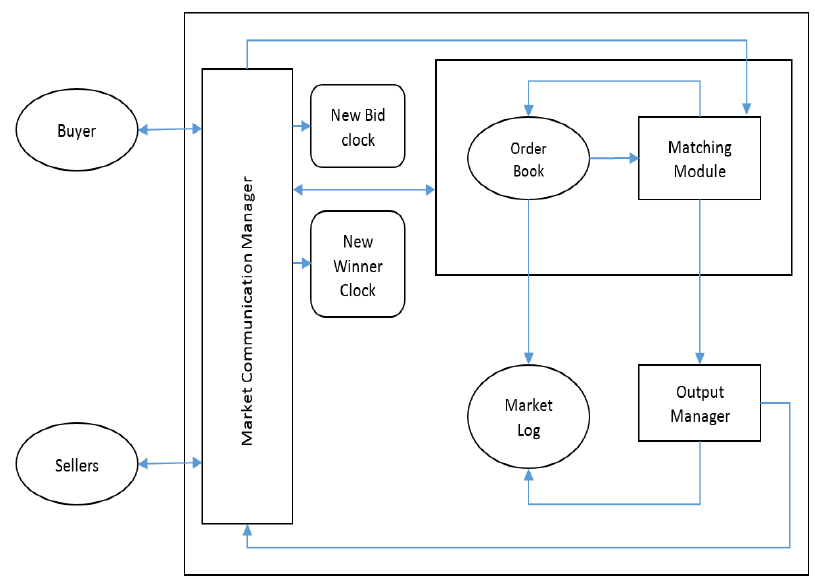
Figure 3. Structure of the